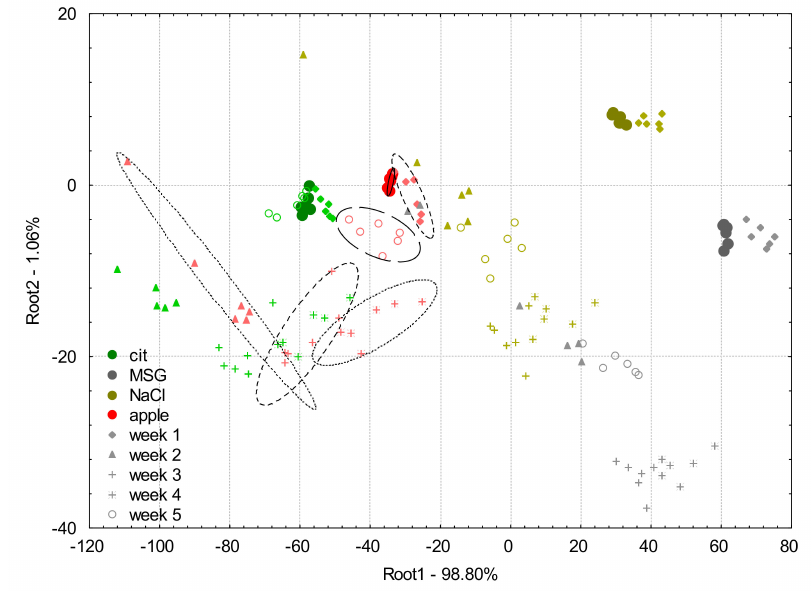
Figure 9. Linear discriminant analysis plots for the drift corrected dataset using the component correction method of the e-tongue measurements of apple juice samples (red symbols) and model solutions: citric acid (green symbols), NaCl (gold symbols), and MSG (gray symbols). The correction was performed based on pairing the first and last week. The solid circles indicate the measurements on week 0 which was used to build the linear discriminant analysis model, and the di ff erent symbols (diamond, triangle, plus, asterisk, and circle) stand for the di ff erent weeks 1–5, respectively.